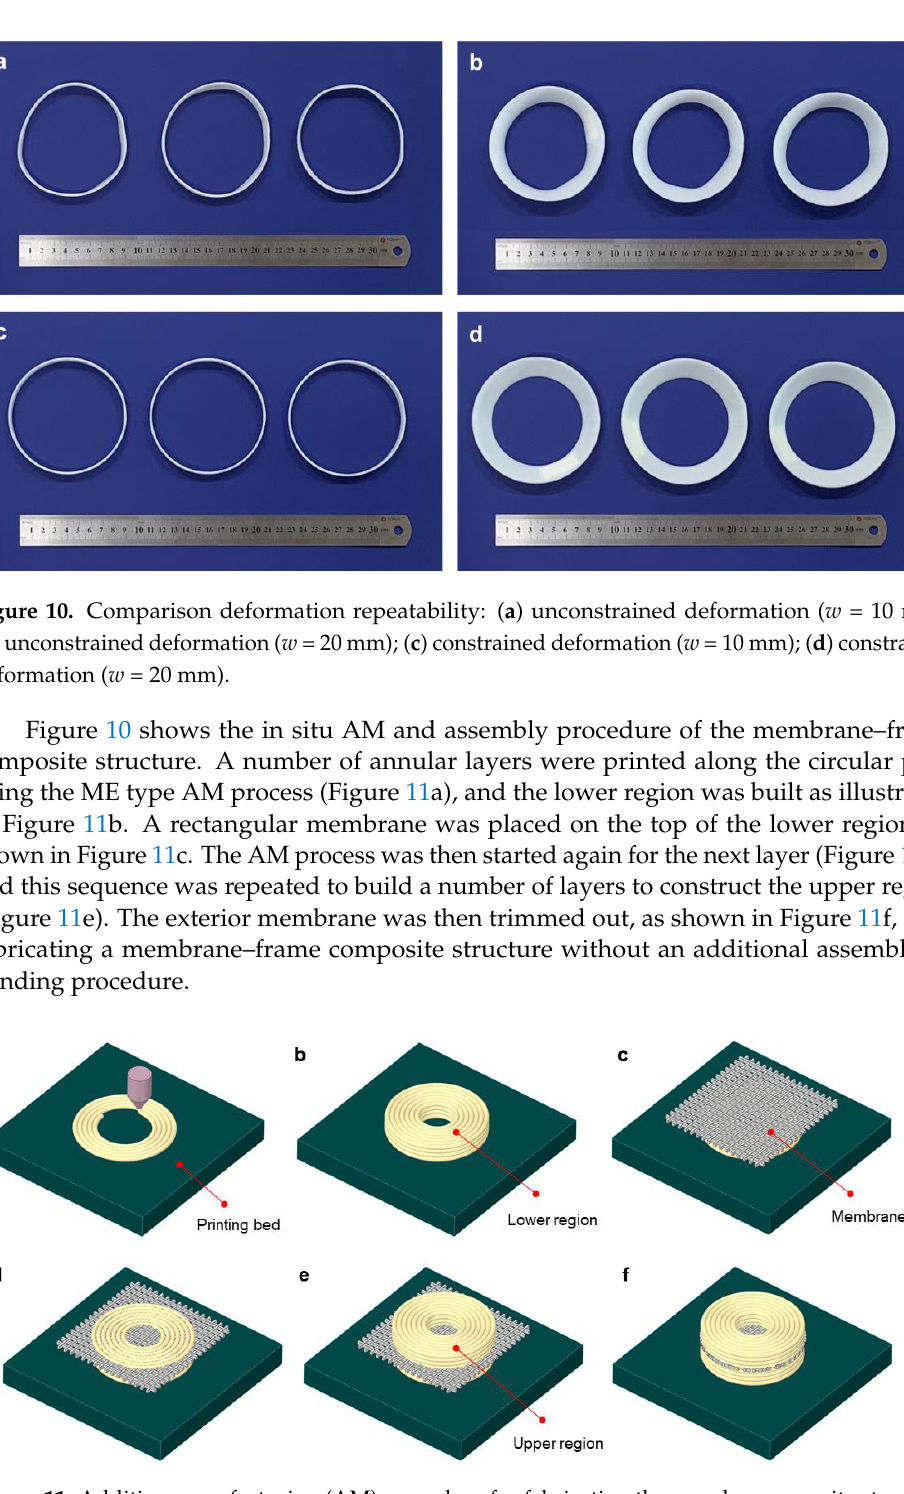
Figure 11. Additive manufacturing (AM) procedure for fabricating the annular composite struc- ture: ( a ) printing of the first layer; ( b ) building of the lower region; ( c ) installation of a thin mem- brane; ( d ) printing of the overlaid layer; ( e ) building of the upper region; ( f ) trimming of the mem- brane.